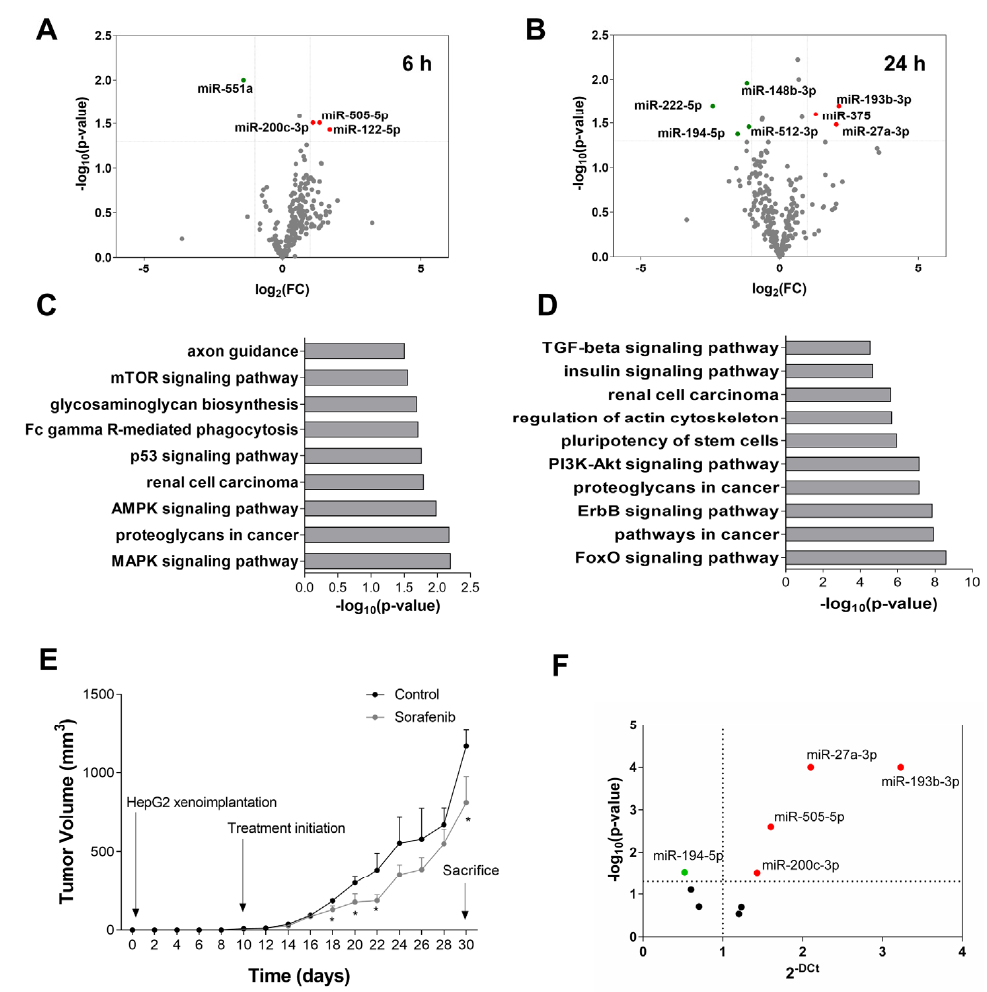
Figure 2. miRNA expression profile induced by Sorafenib in cellular and mouse models. ( A ) Volcano plot of miRNA expression analysis in cell lysates at 6 h of treatment (n = 3). Up-regulated miRNAs are shown in red and down-regulated miRNAs are shown in green. ( B ) Volcano plot of miRNA expression analysis in cell lysates at 24 h of treatment (n = 3). Up-regulated miRNAs are shown in red and down-regulated miRNAs are shown in green. ( C ) Top 10 most significant KEGG pathways enriched in the targets of miRNAs differentially expressed at 6 h of treatment. ( D ) Top 10 most significant KEGG pathways enriched in the targets of miRNAs differentially expressed at 24 h of treatment. ( E ) Tumor volume monitoring during Sorafenib and vehicle treatments. ( F ) Differentially expressed miRNAs in the tumors of subcutaneous mouse models treated with Sorafenib (n = 14).